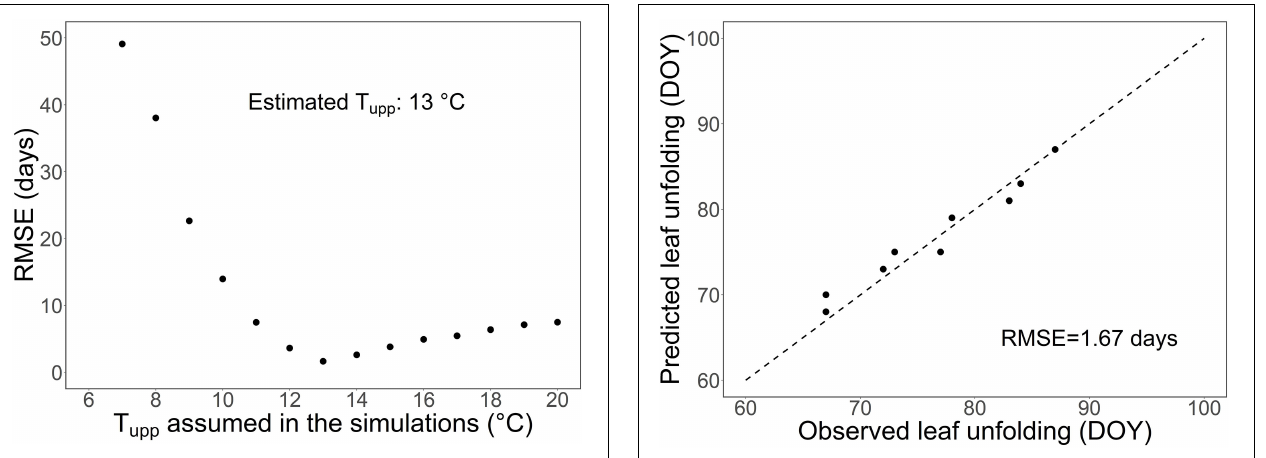
FIGURE 5 | Test of the process-based leaf-out phenology model developed in this study for first-year pecan seedlings by leaf-out observations from a WTC experiment with nine temperature